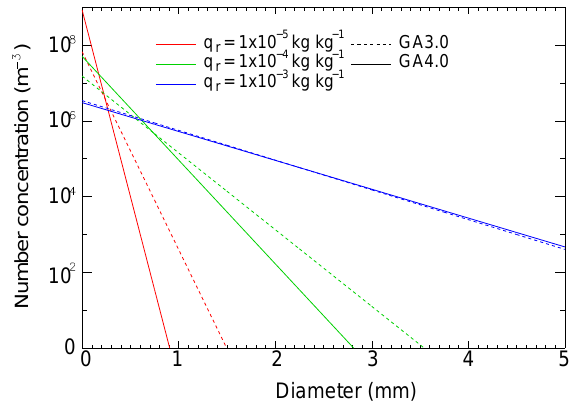
Fig. 1. The difference between the GA3.0 particle size distribution and the GA4.0 particle size distribution, taken from Abel and Boutle (2012) for three different values of the rain mixing ratio ( q r ).